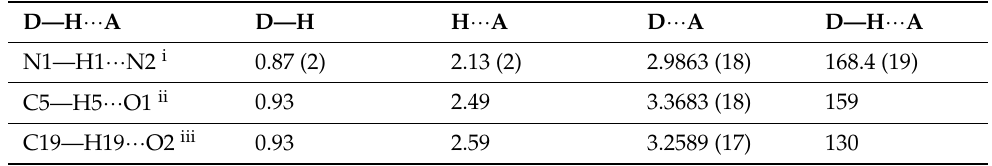
Table 2. Hydrogen-bond geometry (Å, ◦ ) for